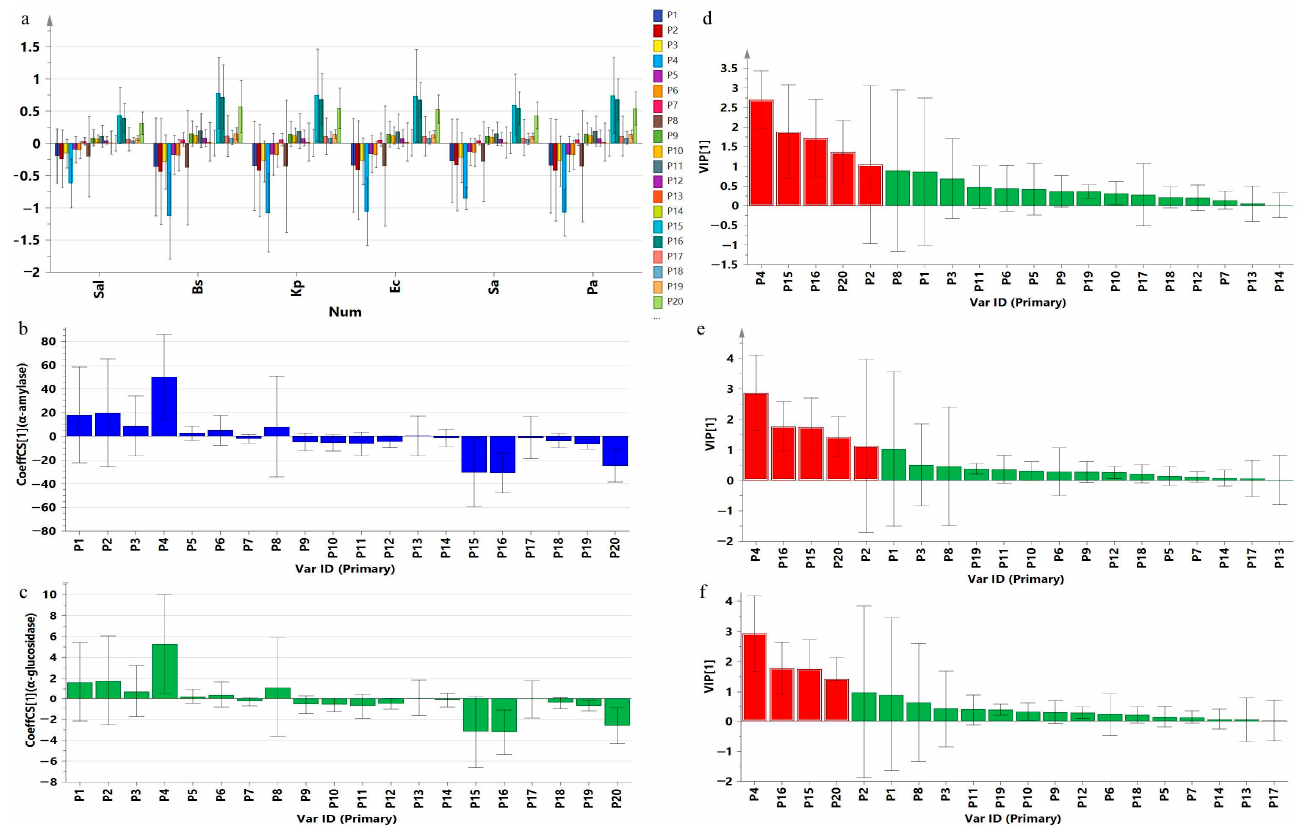
Figure 5. Results of the PLS model analysis. ( a ) Coefficient plot of six bacteria; ( b ) coefficient plot of α -amylase; ( c ) coefficient plot of α -glucosidase; ( d ) VIP plot of six bacteria; ( e ) VIP plot of α -amylase; ( f ) VIP plot of α -glucosidase.